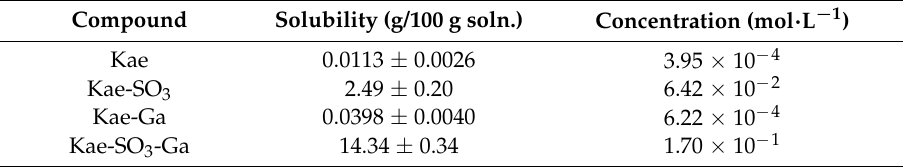
Table 5. The solubility of the Kae-based compounds in water at 30 ◦ C.